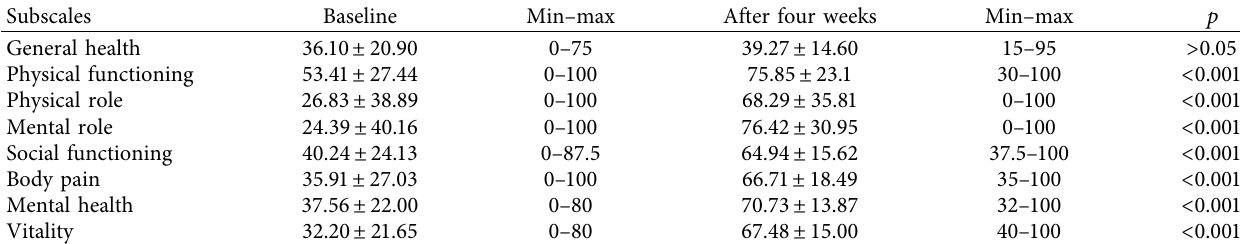
Table 1: Comparison of the quality of life scores at baseline and after four weeks of lavender oil treatment.